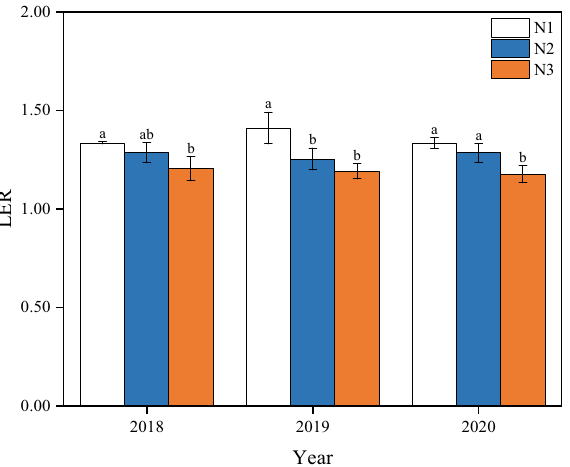
Figure 6. Land use efficiency of wheat/maize intercropping systems under different N managements practices in 2018–2020. N 1 , N 2 , and N 3 represent N-fertilizer applied at 51, 72, and 93 kg N ha −1 as first top-dressing plus 63, 42, and 21 kg N ha −1 at third top-dressing, respectively.